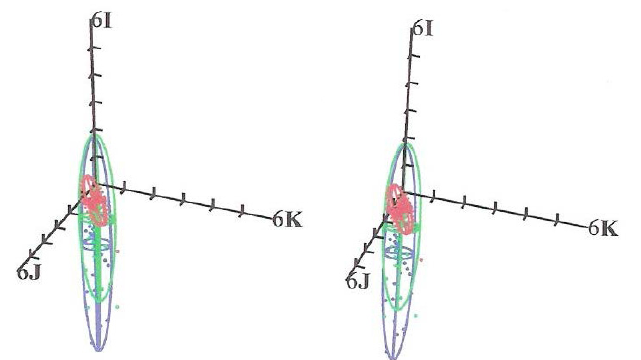
Figure 10: Stereo-pair scatter plot of fifty measurements of refrac- tive state taken from subject 6 wearing a Biofinity silicone hydrogel lens. The origin of the axes is at 0.5 I D.